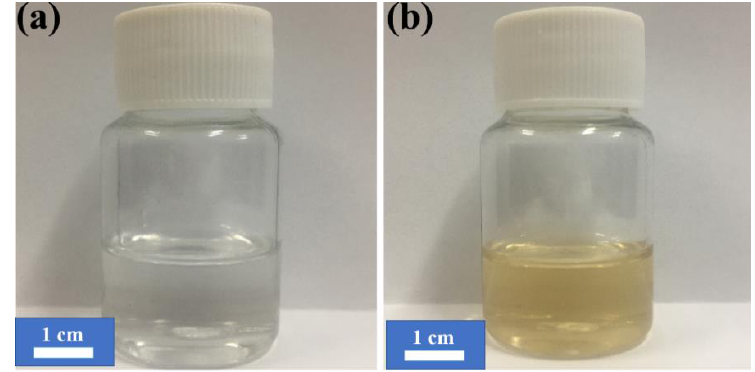
Figure 4. Optical image of LP before ( a ) and after ( b ) the tribological test.